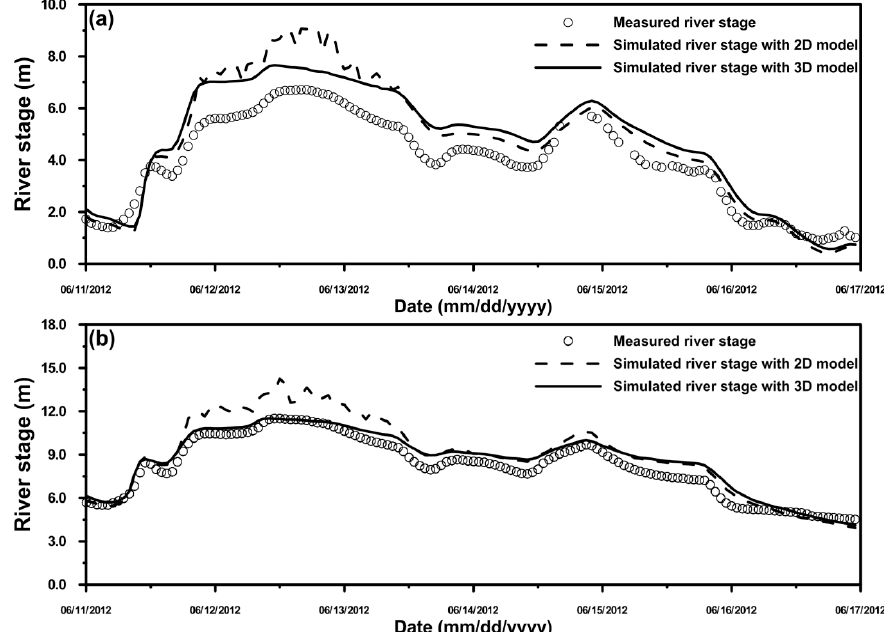
Figure 14. Comparison of the simulated river stages using the 2D and 3D models with the resampled cross-section data under the high flow condition at: ( a ) Mashan Bridge; and ( b ) Xinzhong station.